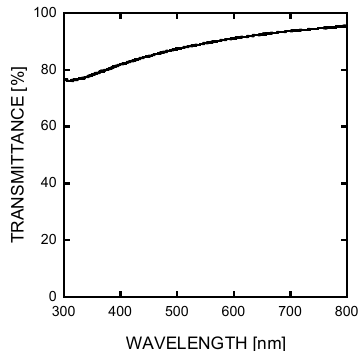
Figure 8. UV–visible spectrophotometric analysis of ALD-deposited ZrO 2 thin films (deposition temperature: 150 °C, CMEN-Zr pulse time: 2.5 s, O 2 plasma pulse time: 9 s, PEALD cycle: 350 cycles (~30 nm), substrate: borosilicate glass).